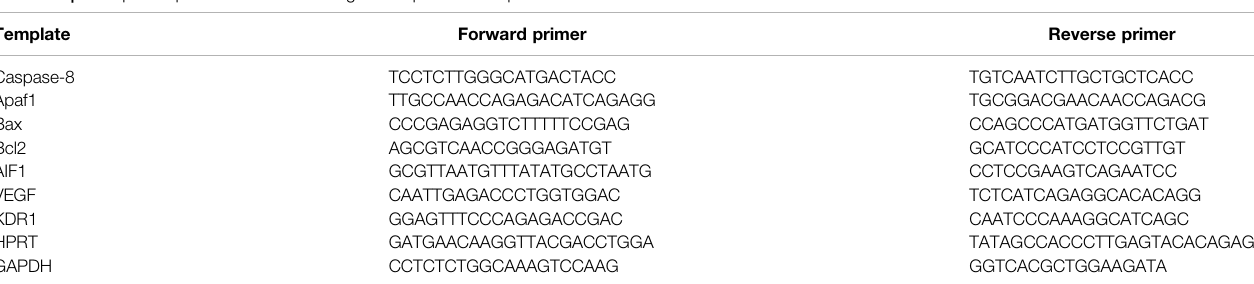
TABLE 1 | The speci fi c primers and reference gene sequences for quantitative real-time RT-PCR. Template Forward primer Reverse primer